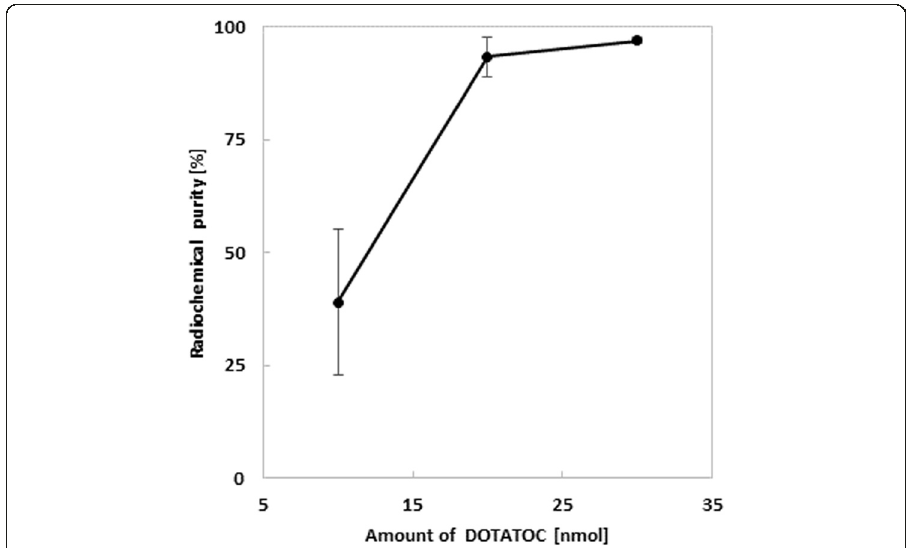
Fig. 5 Radiochemical purity of 68 Ga-DOTATOC depending on the amount of precursor using the